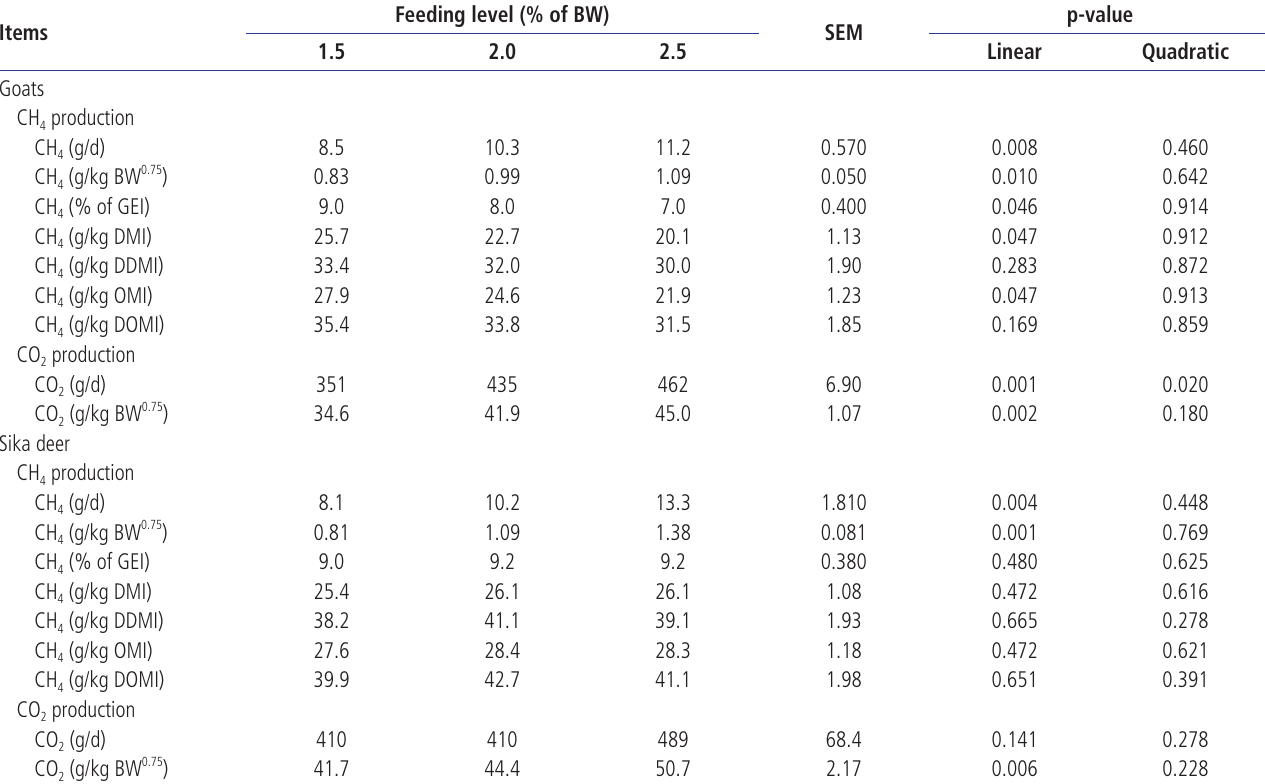
Table 3. Effect of feeding levels on enteric methane and carbon dioxide in goats (Capra hircus hircus) and Sika deer (Cervus nippon